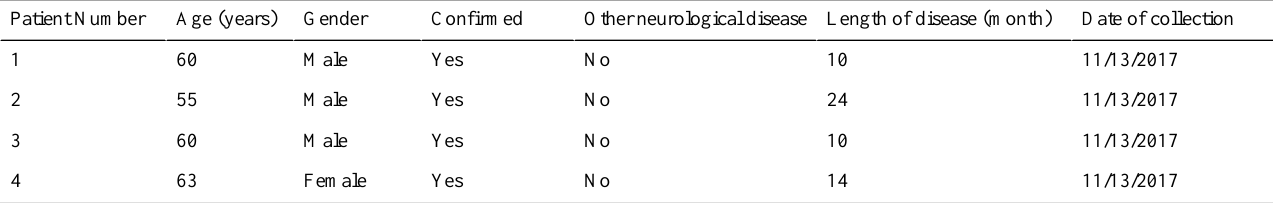
Table 1. Example data collected using the registration form to collect data via video of patients with Parkinson